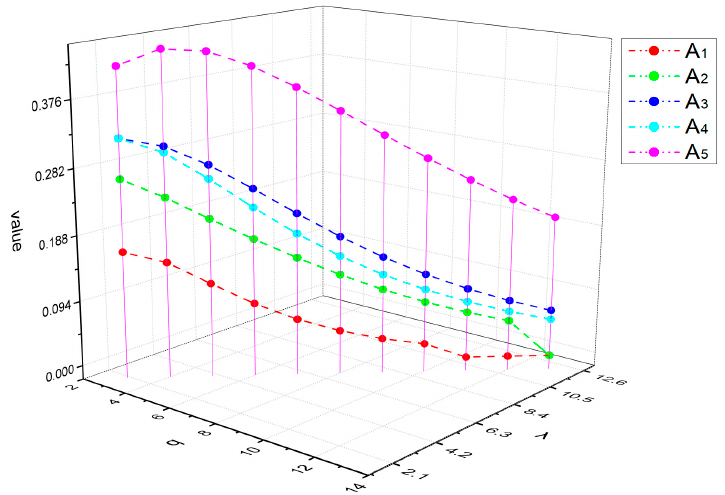
Figure 5. The influence of the simultaneous change of q value and λ in Gq-RONFHA operator on the sorting result.